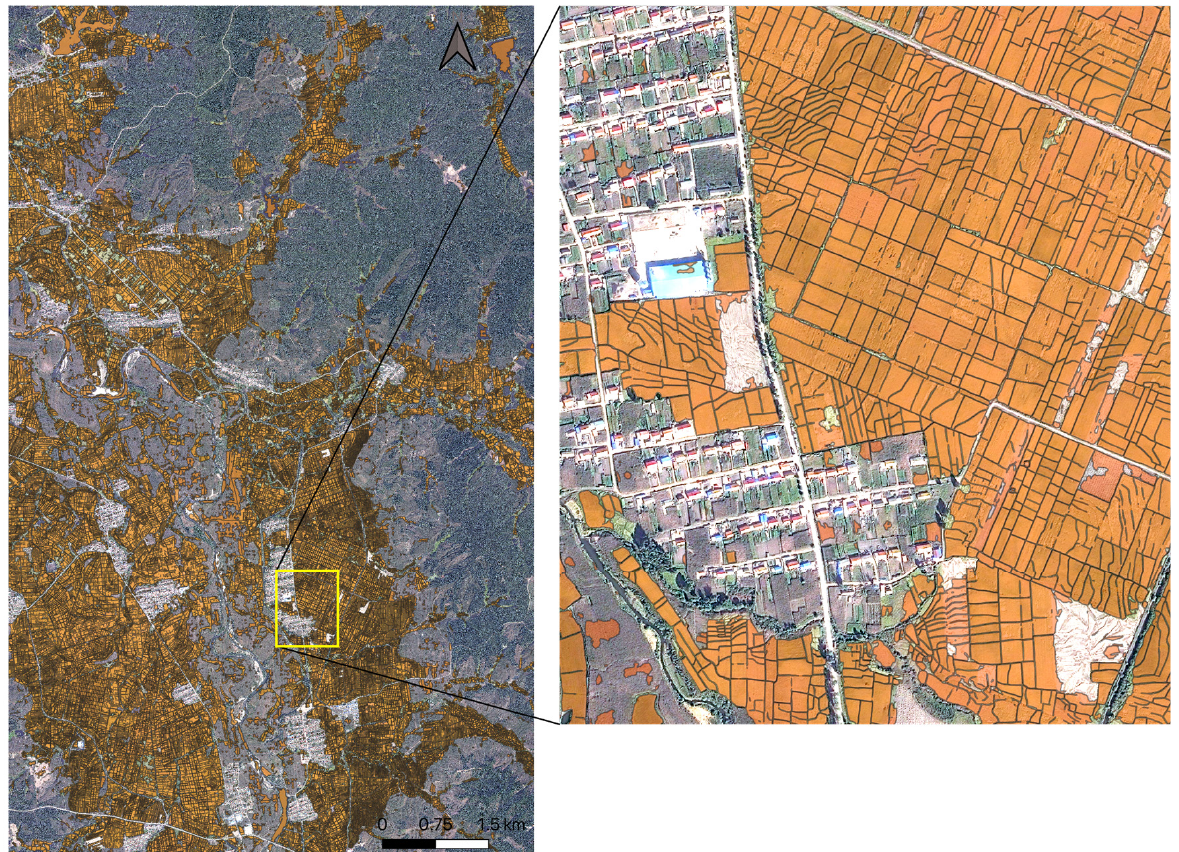
Figure 8. Agricultural field map produced by SeresNet34-based U-net image segmentation model.